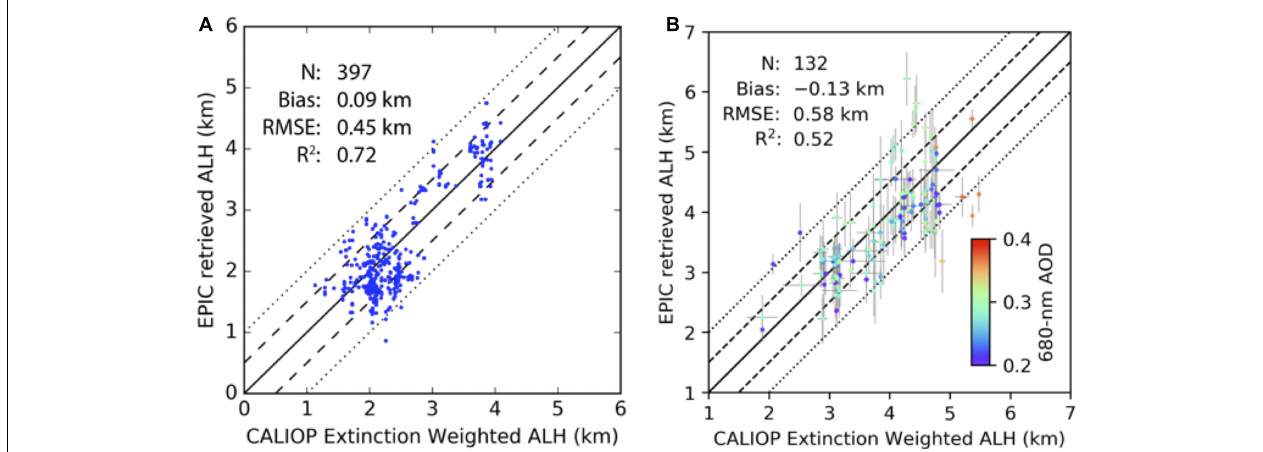
FIGURE 6 | Scatterplots of EPIC retrieved aerosol layer height (ALH) versus CALIOP extinction-weighted ALH. (A) For a dust plume over the Atlantic Ocean on 17 – 18 April 2016. Adapted from Xu X. et al. (2017) with permission from John Wiley and Sons. (B) For smoke plumes over Canada and Northeastern United States on 25 – 26 August 2017. Adapted from Xu et al. (2018a) with permission under Creative Commons Attribution 4.0 License. Also plotted on each panel are the one-to-one line (solid), ± 0.5 km (dashed) and ± 1.0 km (dotted) envelopes, the number of samples (N), bias, root-mean-square error (RMSE), and coefficient of determination ( R 2 ). On (B) , color of each scatter indicates EPIC retrieved 680-nm AOD values, and error bars of each scatter indicates standard deviations for ALH values of the collocated EPIC and CALIOP